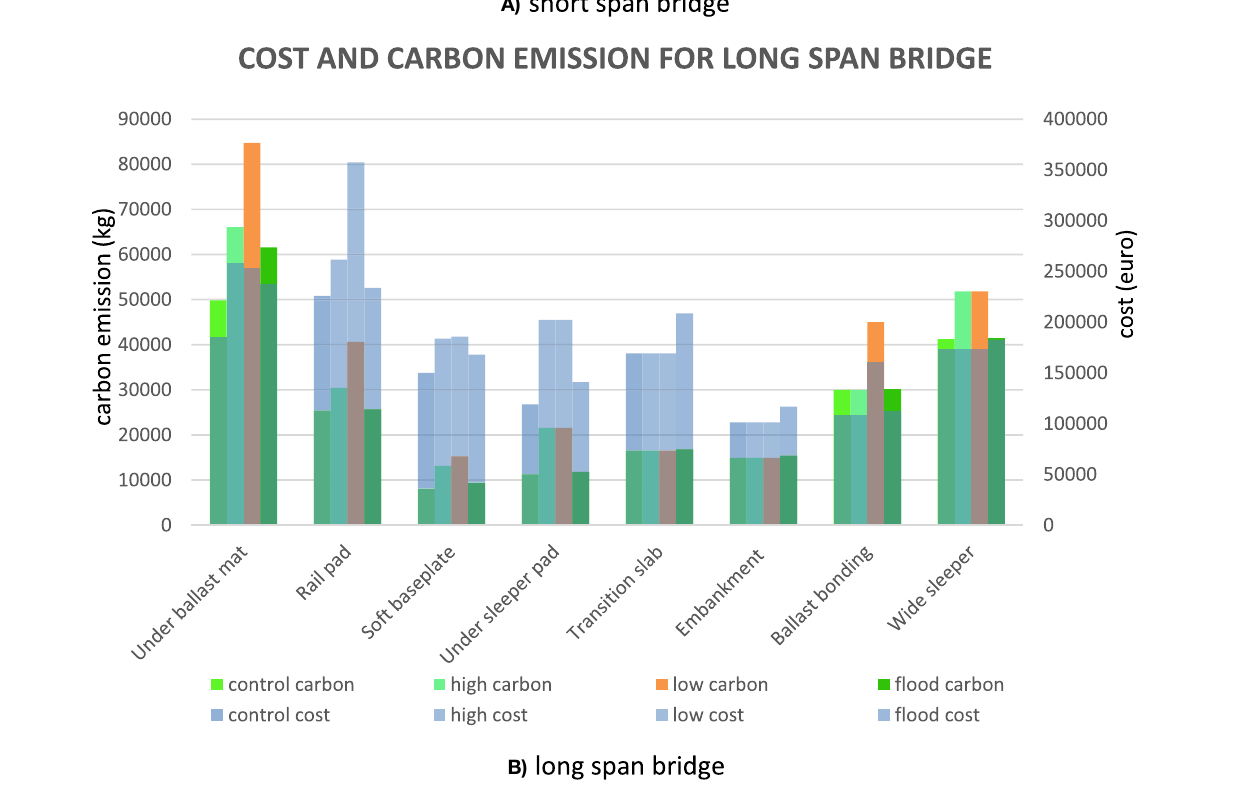
Figure 9 | Cost and carbon emission. (a) Short-span bridge. (B) Long-span